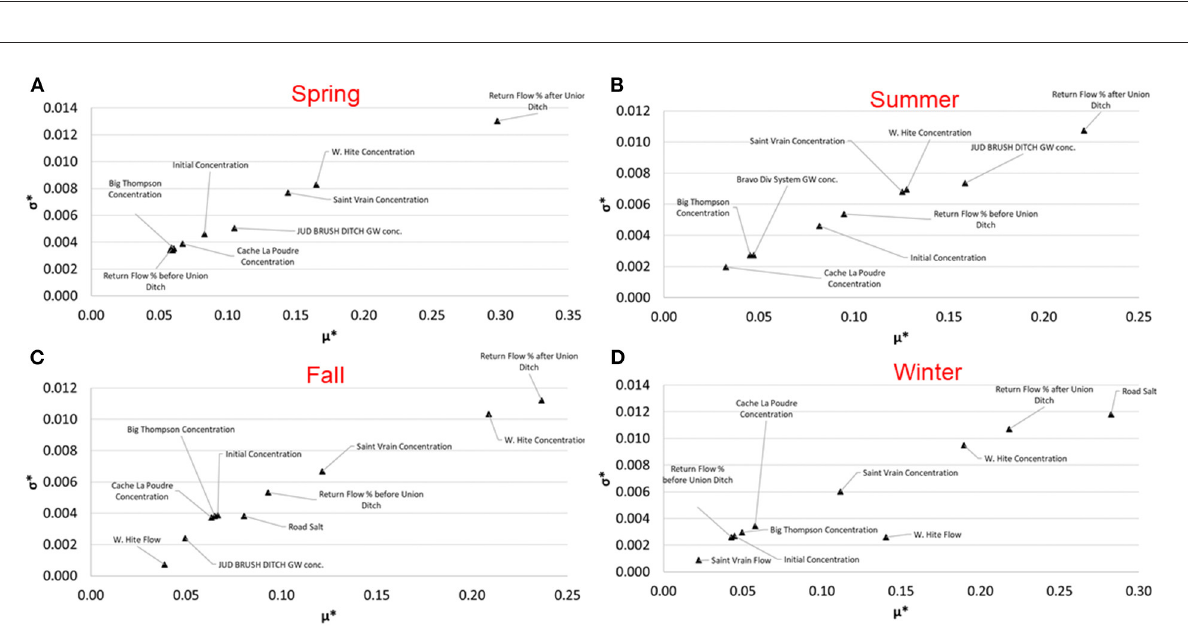
FIGURE9 Results for the spatial (river reach) sensitivity analysis for the (A) urban area and the (B) agricultural area, showing the interaction effects σ * plotted against the sensitivity index µ * for salt model parameters.